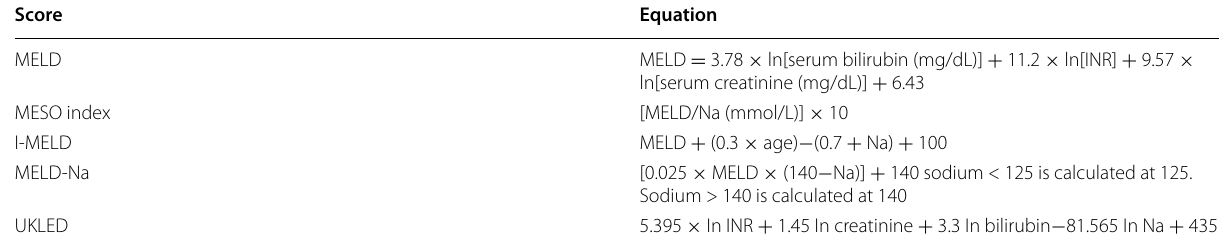
Table 1 MELD and MELD variants compared in our study Score